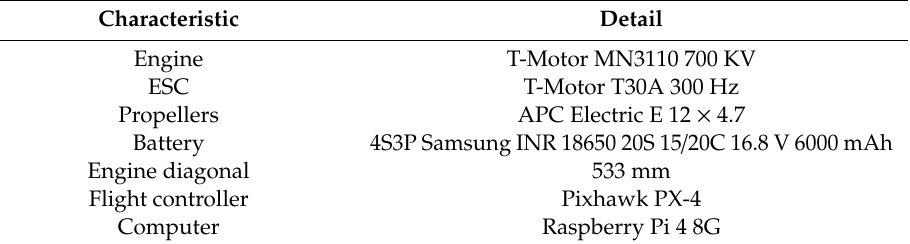
Table 1. Unmanned aerial vehicle (UAV) characteristics.